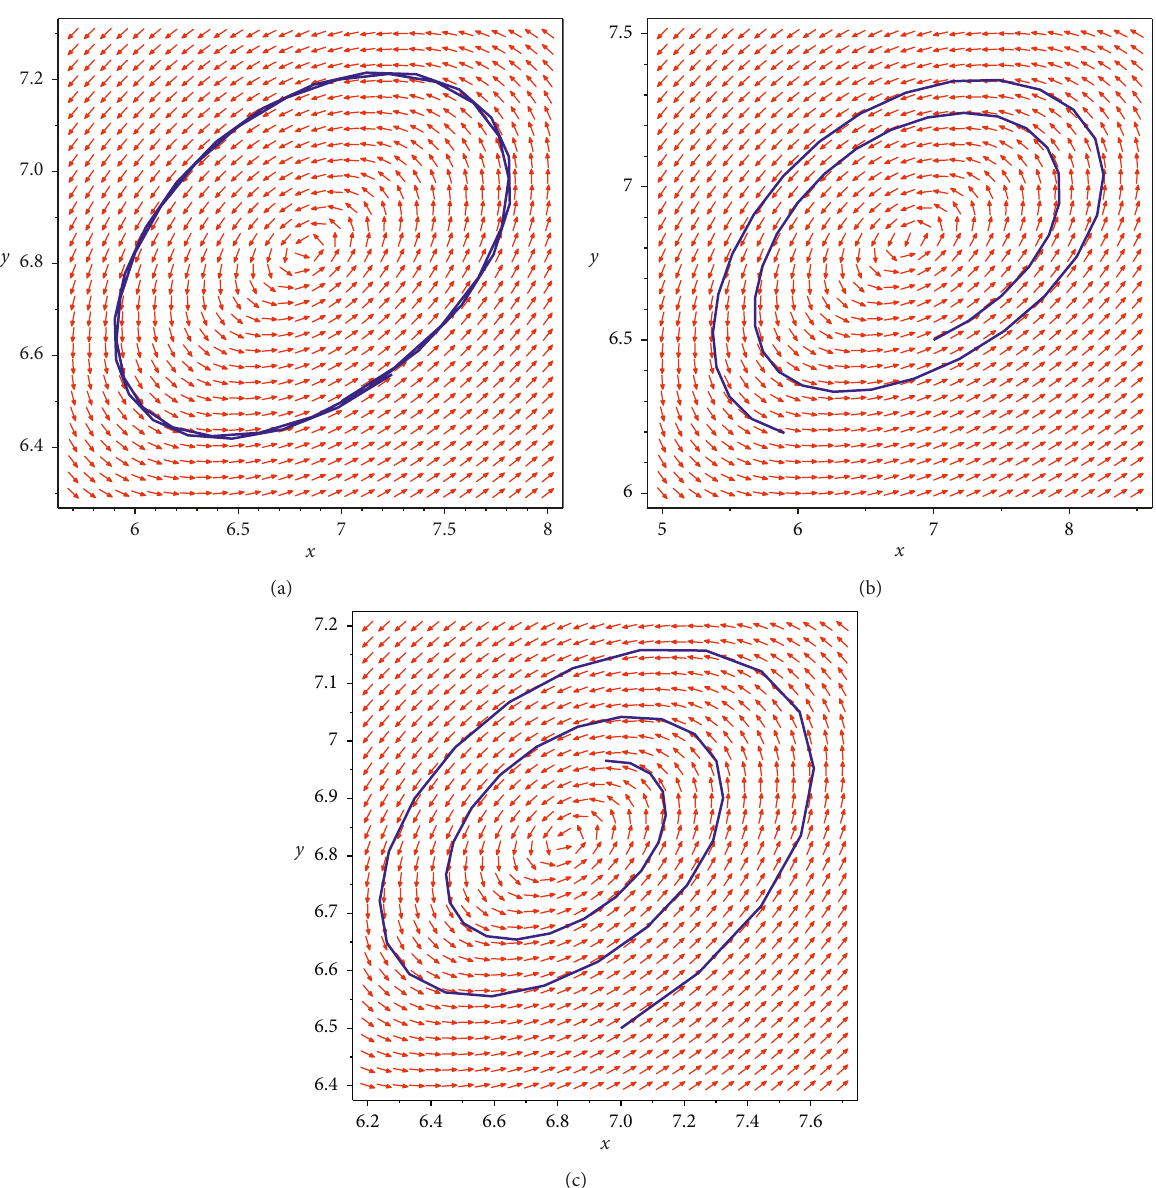
Figure 3: The vector fields of model (71) when u < Kr /4, here u � 2 ,K � 8, and r � 2; the blue part is the trajectory with initial value ( 7 , 6 . 5 ) . (a) The vector fields of model (71) for α � 0 . 292 which holds T � ( r /2 )( 1 − (71) for α � 0 . 25 which holds T > 0; (c) the vector fields of model (71) for α � 0 . 4 which holds T <